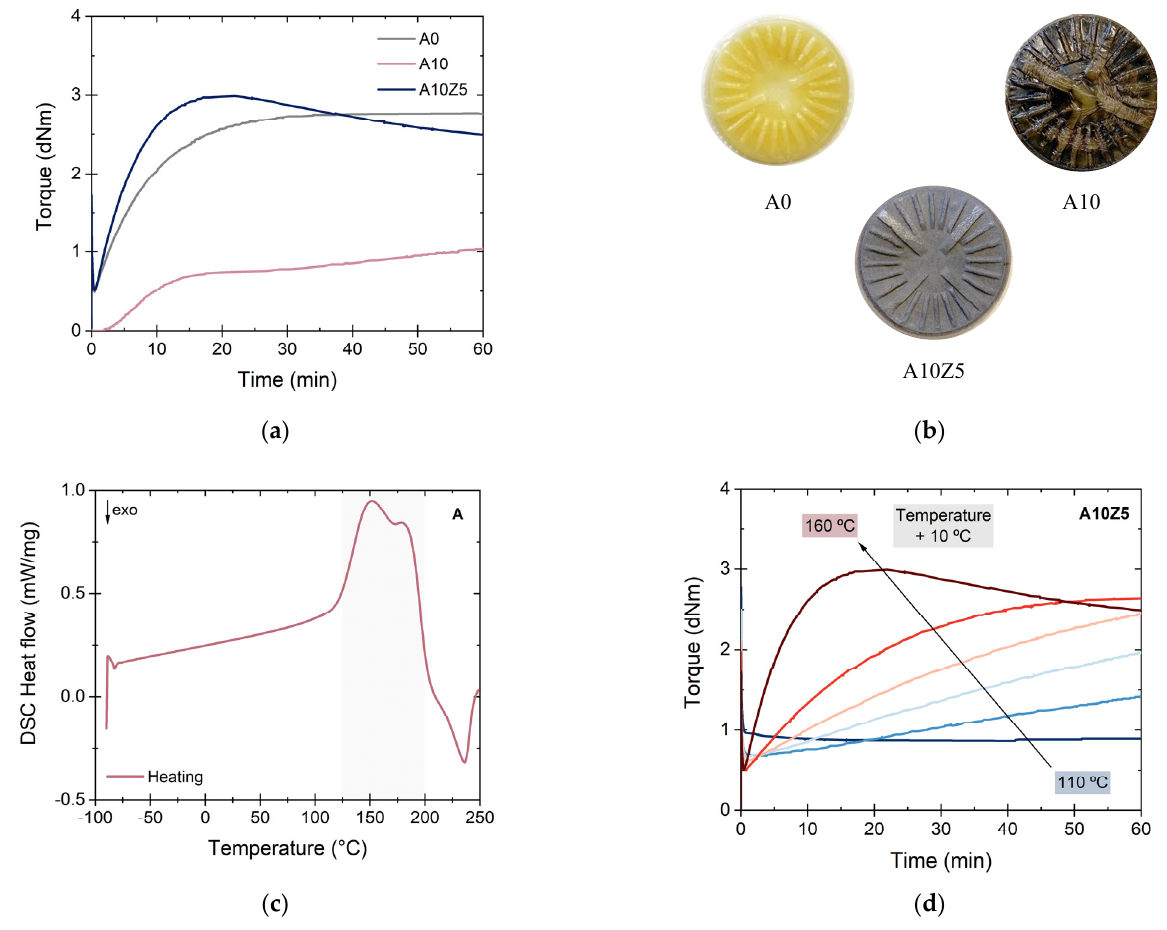
Figure 4. ( a ) Curing curves of preliminary compounds at 160 °C, ( b ) vulcanized rubber samples from the rheometer, ( c ) DSC thermogram of A, and ( d ) rheometric temperature sweep for A10Z5.